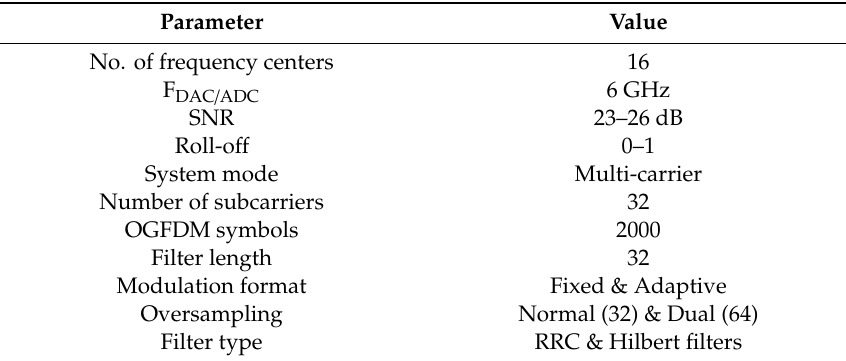
Table 2. System parameters of multi-carrier